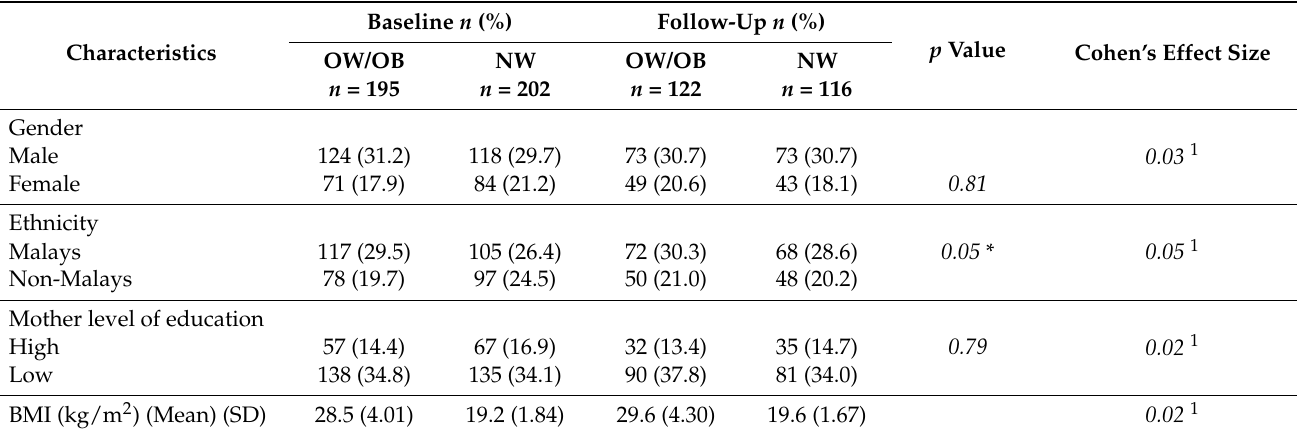
Table 1. Background information of participants at